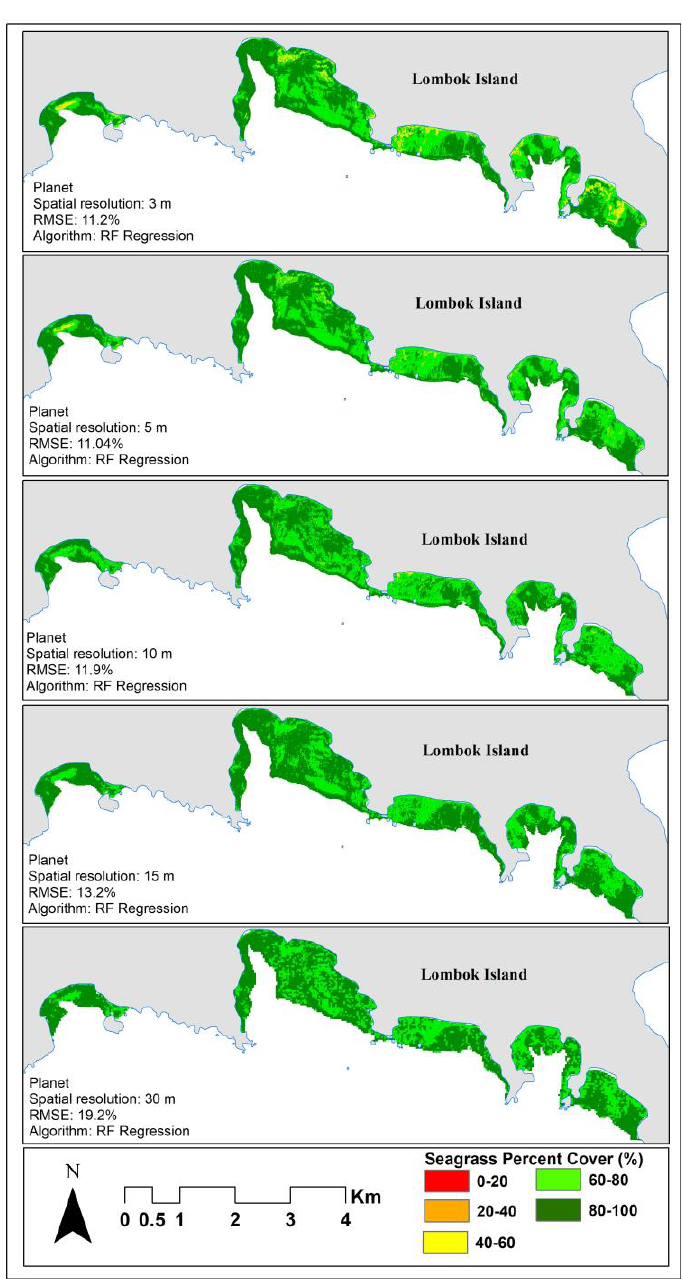
Figure 3. Seagrass PC map from PlanetScope SR image of Lombok